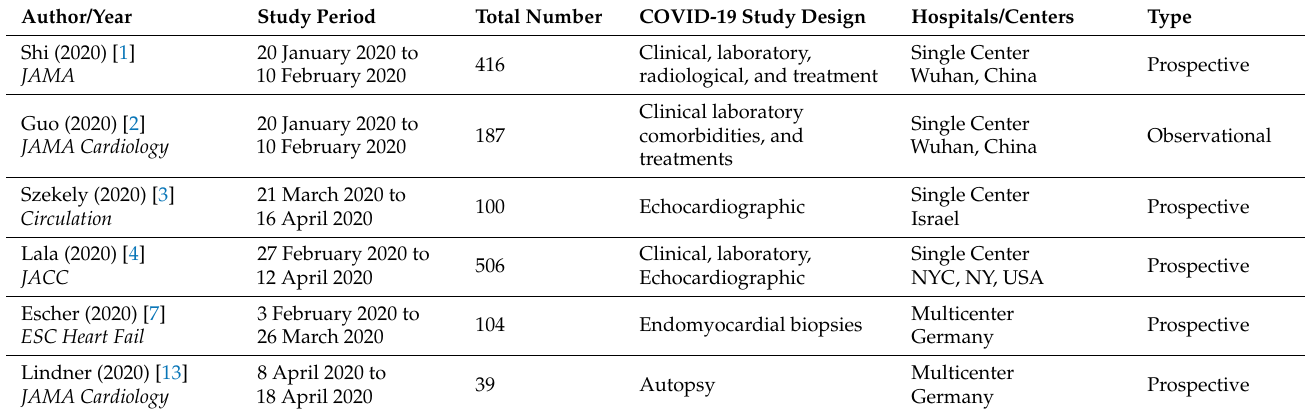
Table 1. Characteristics of the included